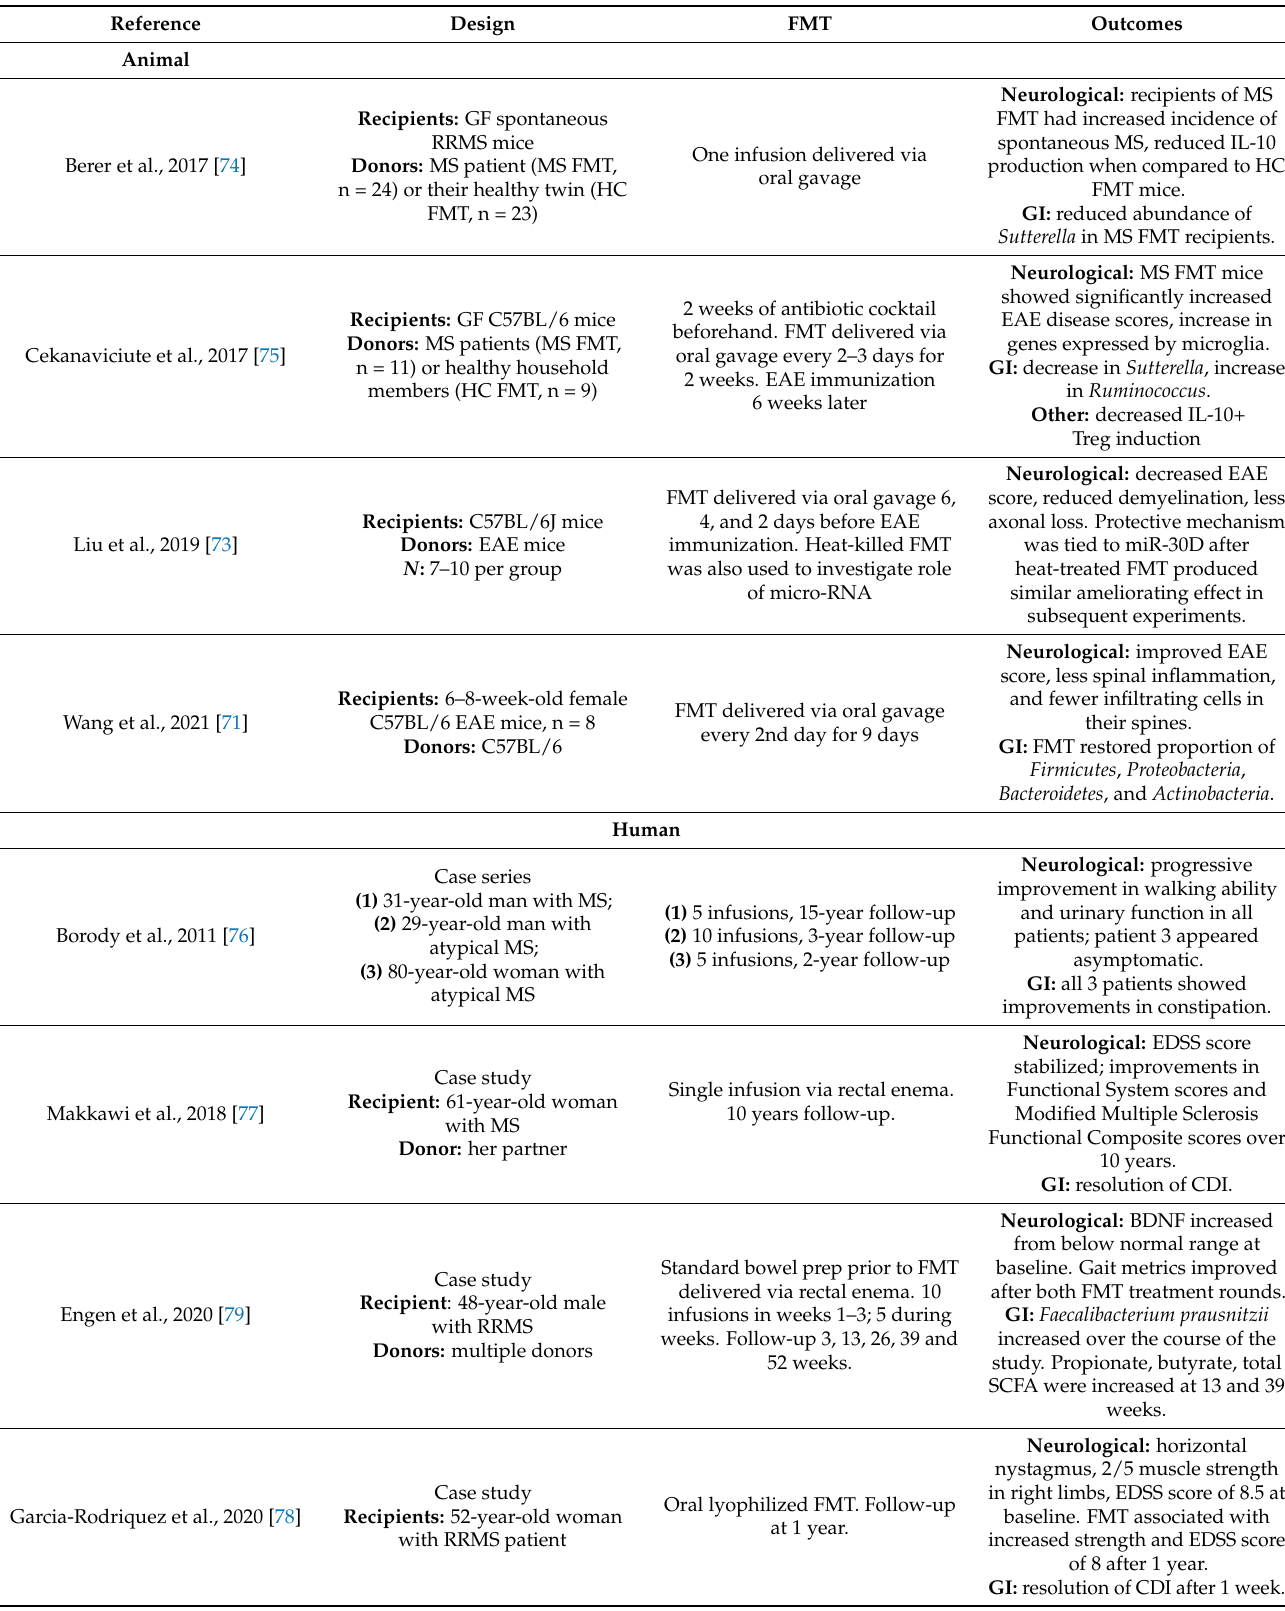
Table 3. MS research involving